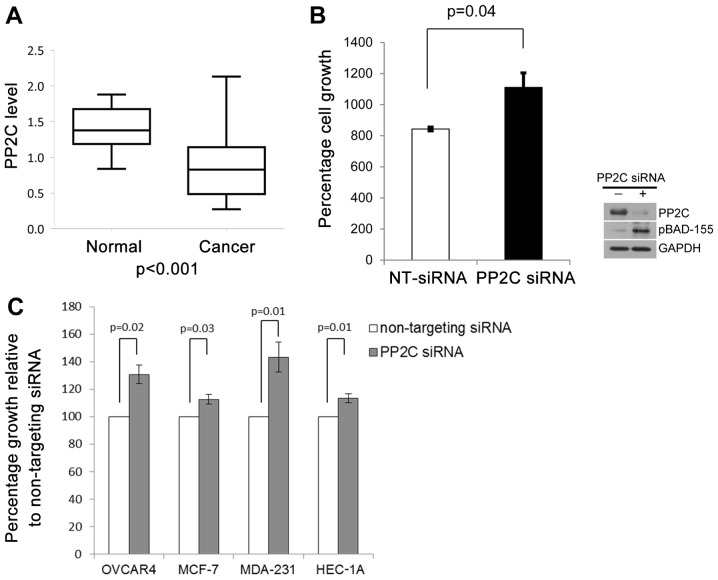
Protein phosphatase 2C (PP2C) expression influences the development and progression of cancer. (A) Ovarian cancer samples (n=67) expressed lower mRNA levels of the BAD-mediated apoptotic pathway phosphatase PP2C than normal ovary samples (n=9), as shown by RT-qPCR (p<0.001). (B) The depletion of PP2C resulted in the increased expression of phosphorylated BAD (pBAD) at Ser-155 (pBAD-155), as shown by western blot analysis, and increased cell growth rates, as shown by MTS assay in the immortalized normal ovary cell line, IVAN. (C) The depletion of PP2C conferred a growth advantage to the cancer cell lines, OVCAR4 (ovarian cancer), MCF-7 (breast cancer), MDA-MB-231 (MDA-231; breast cancer), and HEC-1A (endometrial cancer). Error bars depict the standard error of the mean. Student’s t-test p-values were derived from the average of 3 replicate experiments.